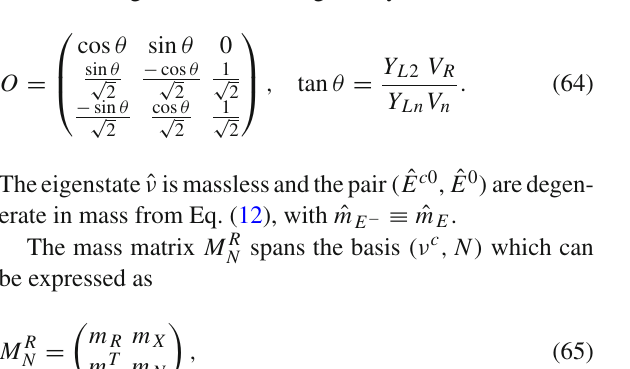
The curves from top to bottom depict, V 2 / V = 0 . 6 , 0 . 5 , 0 . 1 , 10 − 4 , respectively. The orange/red solid (dashed) lines denote the lower bounds obtained from W 2 ( W 3 ) and the blue line represents Z 5 , which provides the most severe bound on V . The lowest value of V consis- tent with the current LHC gauge boson resonance search bounds is for V 2 / V = 0 . 1 and V / V R (cid:2) 0 .